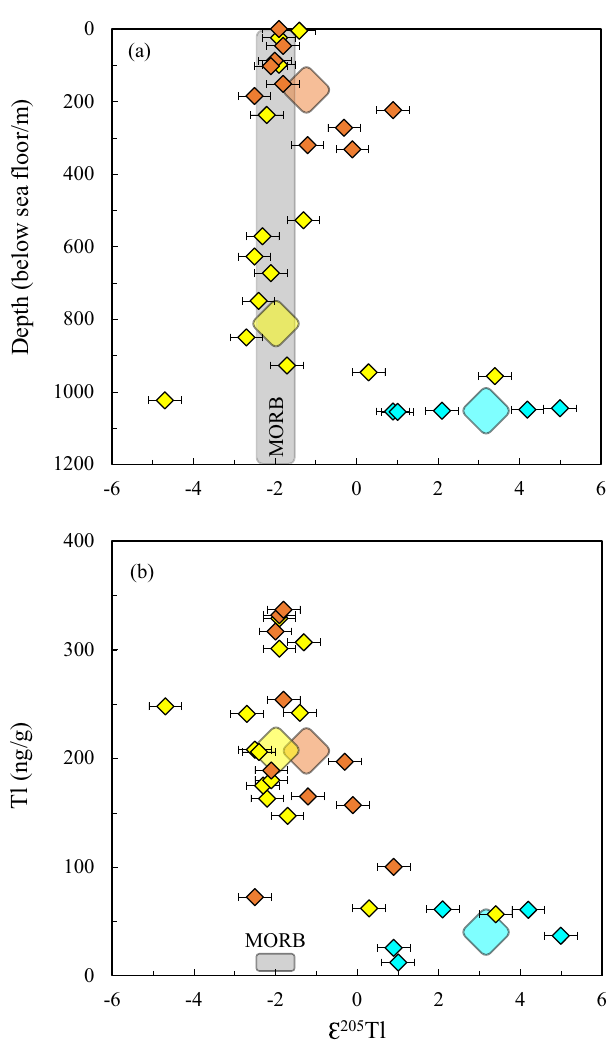
Fig. 2 | Thallium concentration and isotope characteristics of subducting materials outboard of Kamchatka arc. Thallium isotope compositions plotted against ( a ) depth and ( b ) Tl concentrations for sediments from Deep Sea Drilling Project (DSDP) Site 192 and Ocean Drilling Program (ODP) Hole 881C and Hawaii- Emperor Seamount Chain (HESC) basalts from DSDP Site 192. The lighter shaded areasindicatetheaverageTlconcentrationandisotopecompositionsofmid-ocean ridge basalt (MORB) 58,59,66 . Large symbols indicate the concentration weighted average Tl isotope compositions and concentrations for each of the two sediment cores and